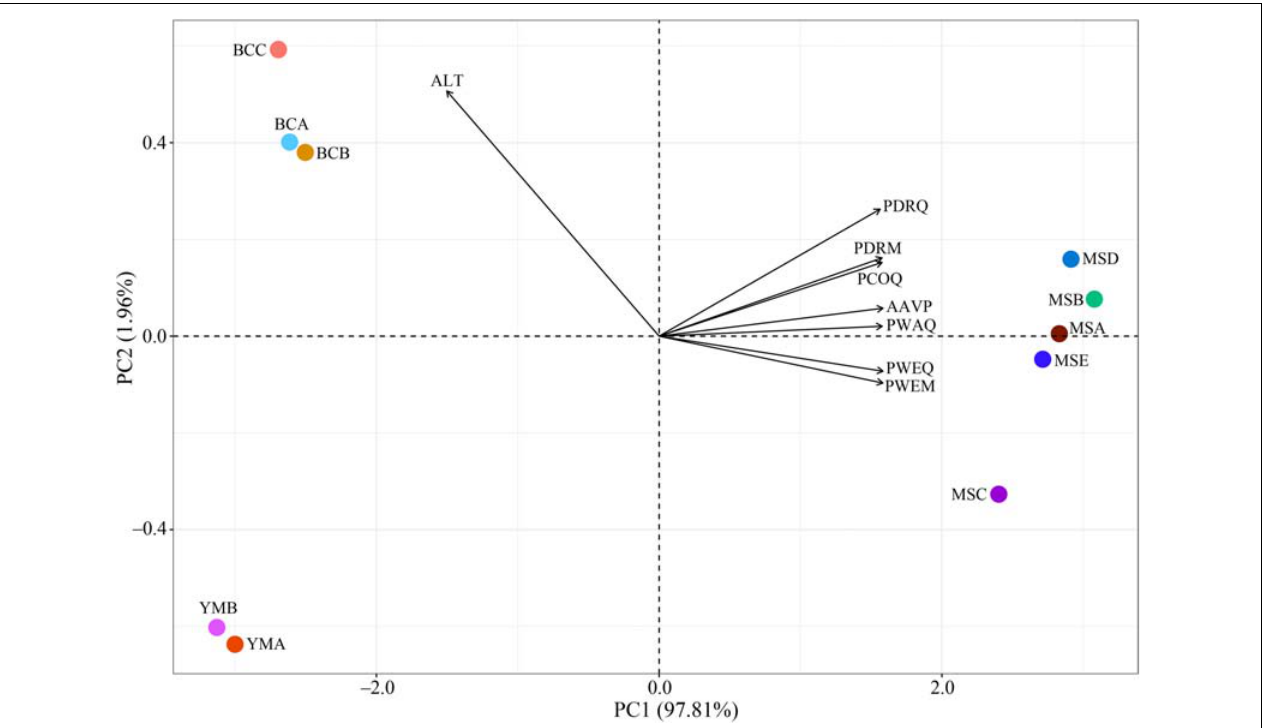
FIGURE 3 | Principal component analysis (PCA) of environmental variables of 10 P. emblica populations. AAVP, annual average precipitation (mm); PWEQ, precipitation of the wettest quarter (mm); PDRQ, precipitation of the driest quarter (mm); PWEM, precipitation of the wettest month (mm); PDRM, precipitation of the driest month (mm); PWAQ, precipitation of the warmest quarter (mm); PCOQ, precipitation of the coldest quarter (mm); ALT, altitude (m). All environmental variables were normalized by z